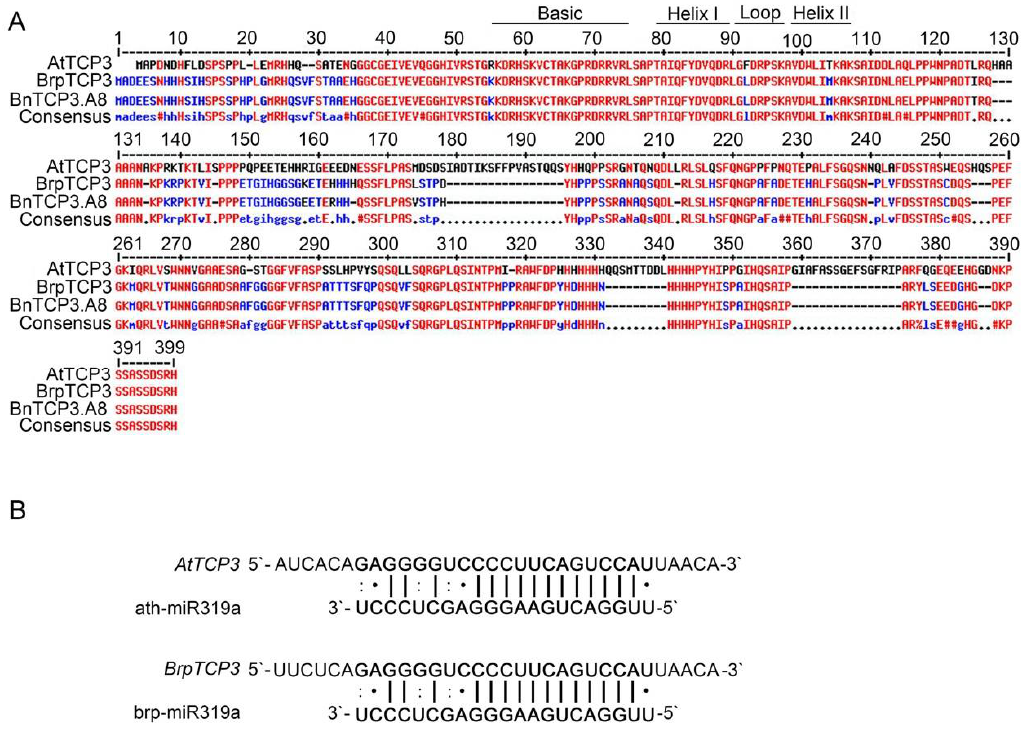
Figure 5. Alignment of putative TCP3 proteins in Arabidopsis thaliana , B. rapa, and B. napus and miR319a target sites of AtTCP3 and BrpTCP3 . ( A ) Amino acid sequence alignment of TCP3 proteins in Arabidopsis , B. rapa , and B. napus. The TCP domains are represented by black solid lines. ( B ) Reverse complementation between mature miR319a and TCP3 mRNA.